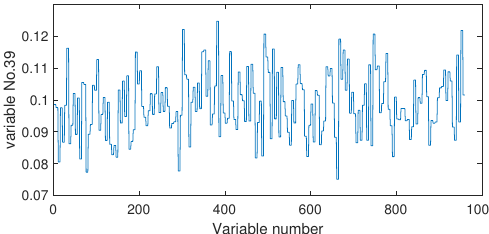
Figure 17. Fault isolation results for fault F19 based on distance correlation.